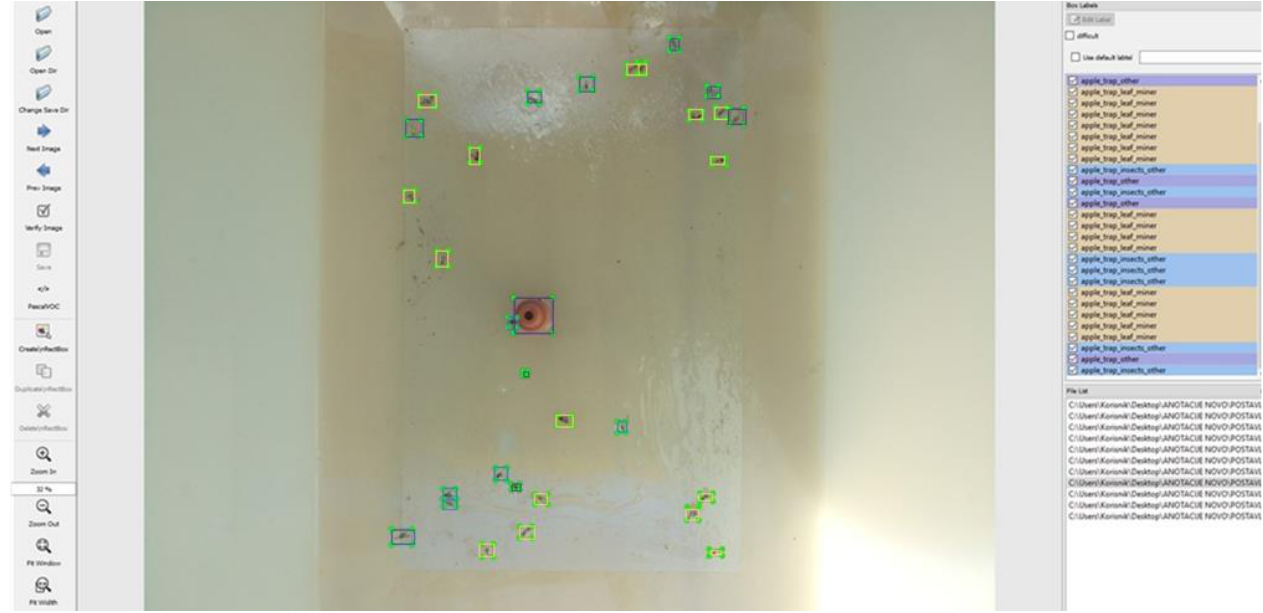
Figure 2. Annotated class MINES (L . malifoliella adults) — marked with yellow bounding boxes, class OTHER (other objects) marked with purple bounding boxes, class INSECTS (other insects) marked with blue bounding boxes in the LabelImg program from images of adhesive pads.